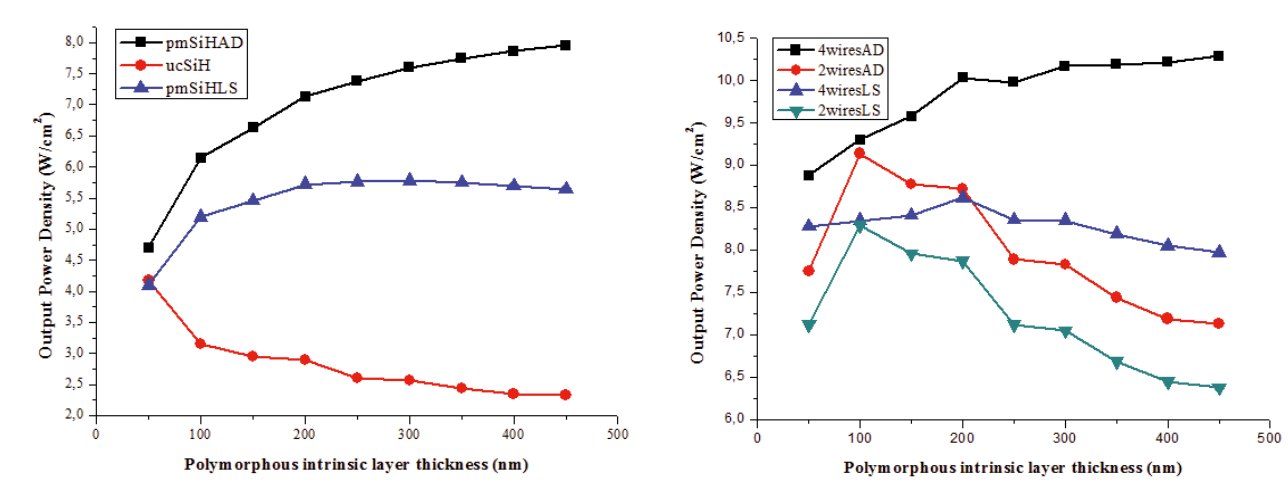
Fig. 6. Maximum output power of both tandem structures as a function of pm-Si:H i-layer thickness (AD and LS state